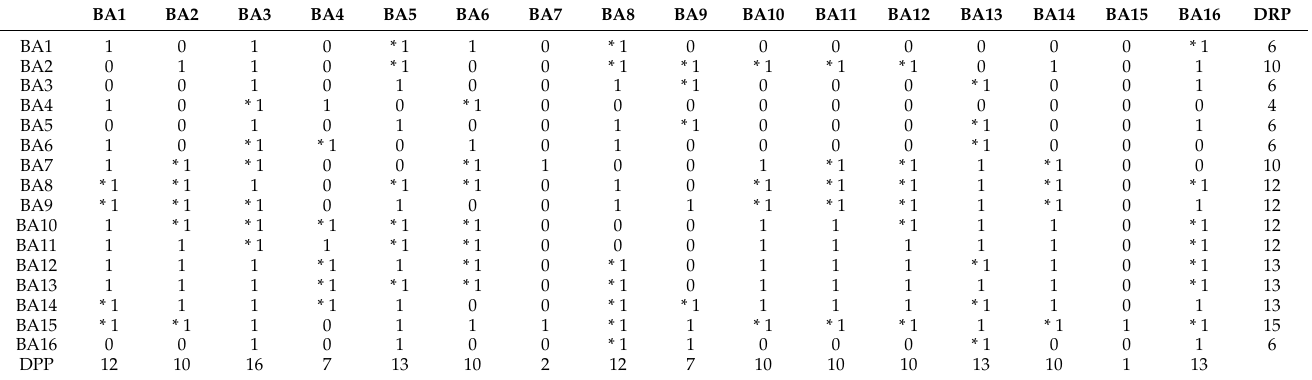
Table 7. Final reachability matrix of the barriers as derived from the SSIM showing